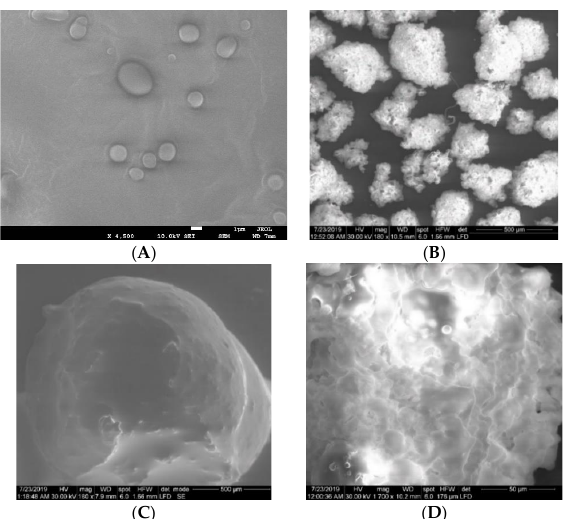
Figure 1. SEM images of microparticles (MPs) of chitosan loaded with ellagic acid (EA-CHIT) ( A ) and, additionally, coated with eudragit S100 (EA-CHIT-ES) at various magnifications: 180 X ( B ) 800 X ( C ) and 3000 X ( D ) showing EA-CHIT MPs entrapped within the ES100 coat.